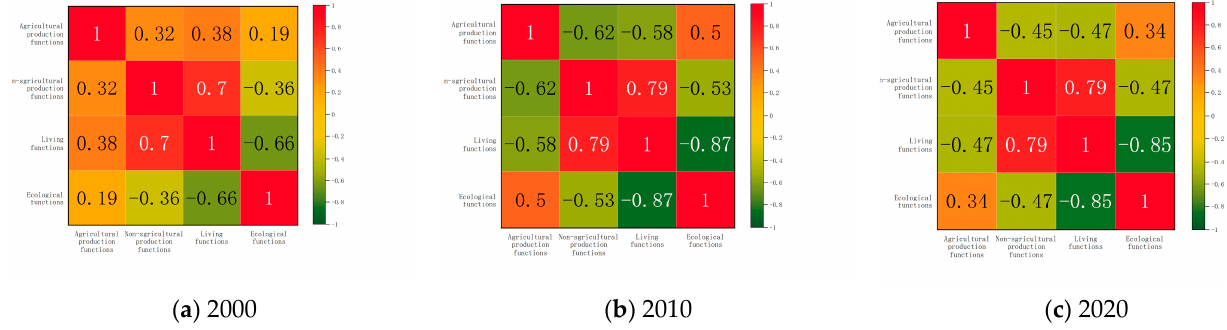
Figure 7. Person-related characteristics of land use functions in the Yangtze River Delta region, 2000–2020.